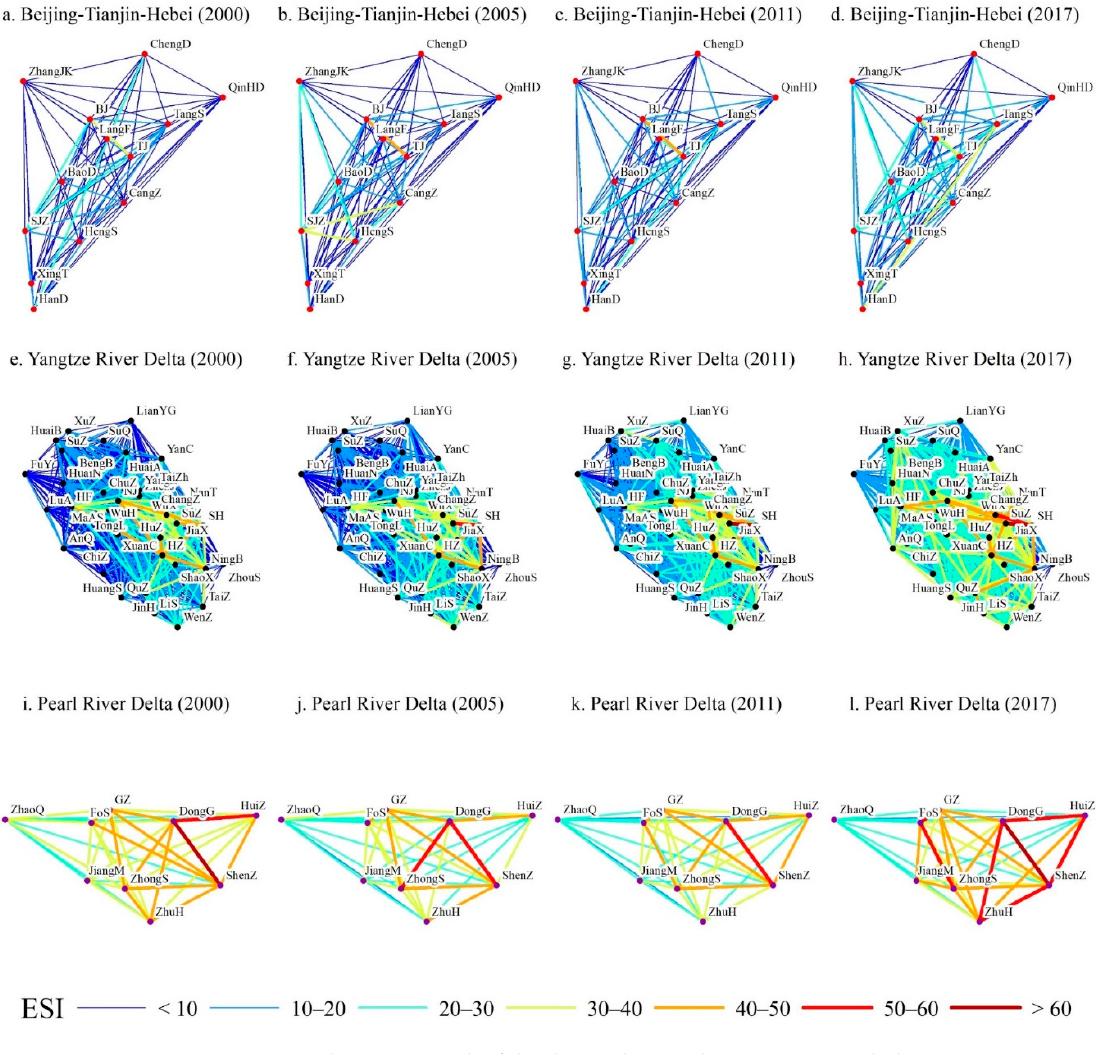
Figure 5. The ESI network of the three urban agglomerations. (Each dot represents a city. The redder and wider the line between cities, the fiercer the export competition between the two cities.)